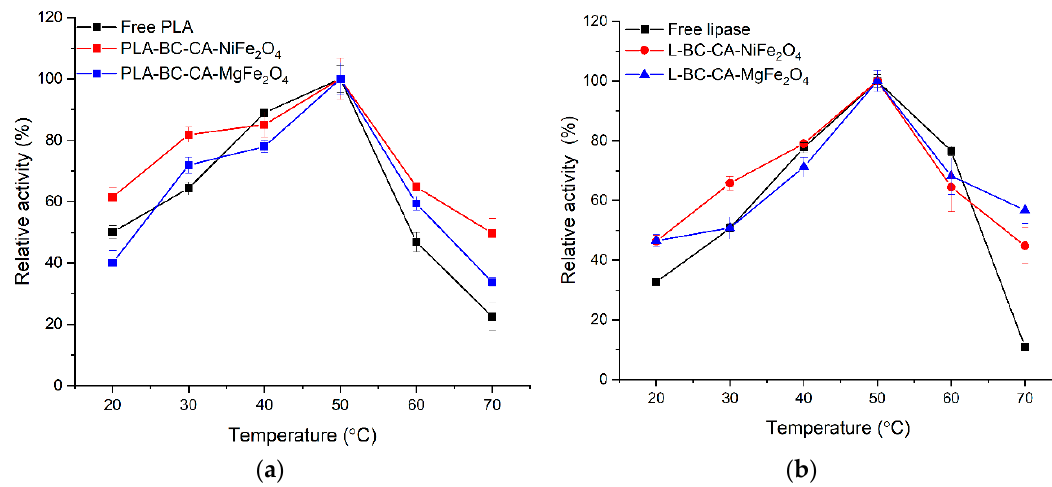
Figure 8. Effect of temperature on the activity of free and immobilized phospholipase A ( a ) and lipase ( b ).